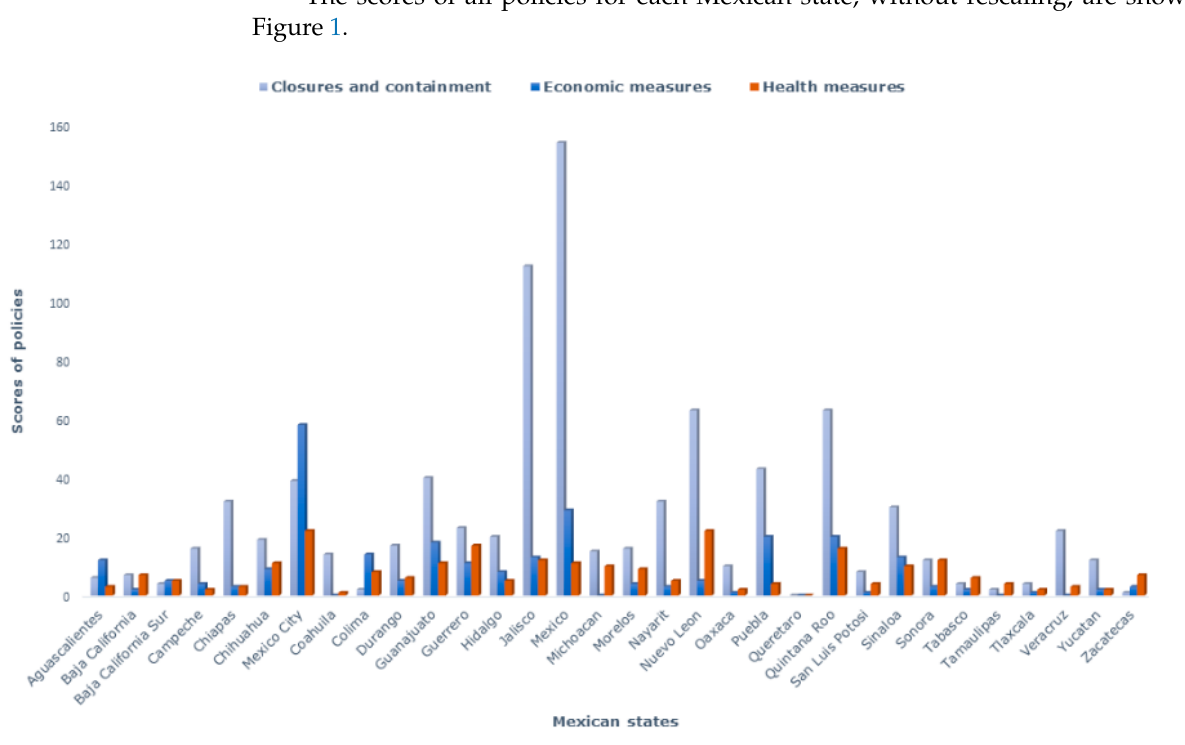
Figure 1. Categories of policies to face COVID-19 in Mexico.